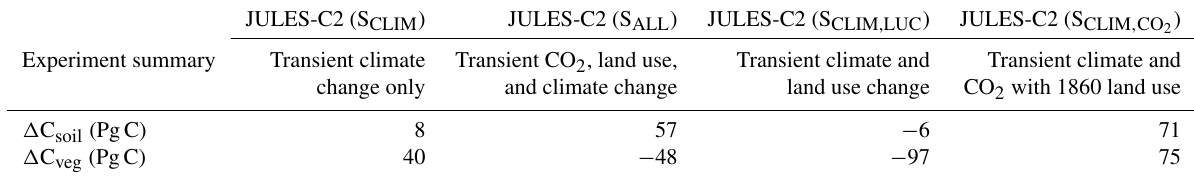
Figure 6. Global mean gross primary productivity (GPP), net primary productivity (NPP), heterotrophic respiration ( R het ), net biome pro- ductivity (NBP = GPP − R het ), vegetation carbon (C veg ), and soil carbon (C soil ). Global means are shown for the S CLIM,LUC , S CLIM , CO and S ALL experiments summarized in Table 5. Table 5. Simulated change in average fluxes and stocks from the period 1900 to 1909 to 2000 to 2009 in JULES-C2. Positive values indicate a gain of carbon by the land